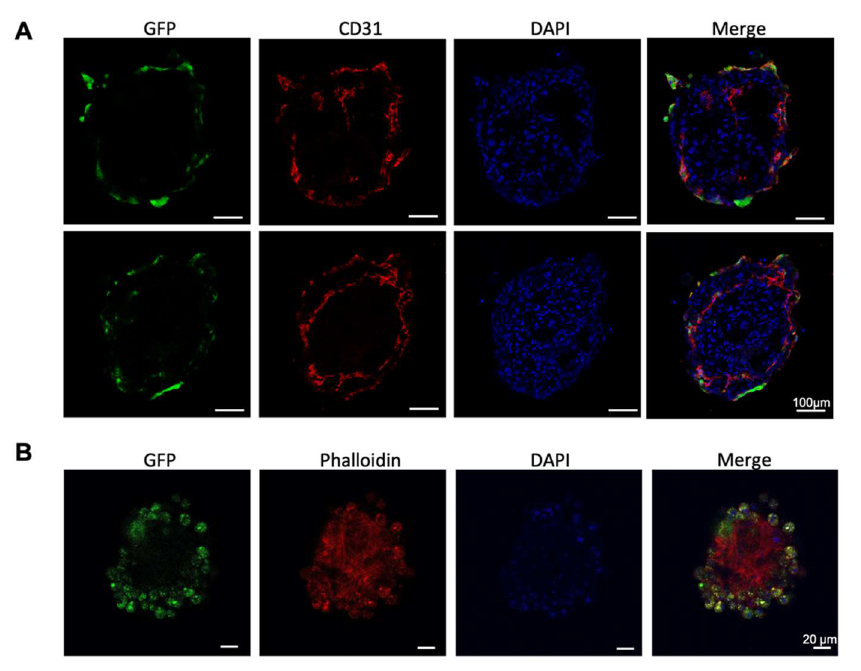
Figure 4. Endothelial cells infiltrate the normal surrounding microenvironment from vascularized PDT. Immunofluorescence analyses for vascularized PDTs. ( A ) cryosection staining; ( B ) whole mount staining. ( C ) Experimental scheme for the combination of vascularized PDT and fibrin gel. ( D ) infiltration of endothelial cells from PDO to fibrin gel. 3.4. Vascular Network Connection between Vascularized Microenvironment and Vascularized PDT The main purpose of this study is to connect the pre-vascularized PDT with the vas- cularized microenvironment. Consequently, PDTs pre-vascularized with RFP-labeled HUVECs were laid on a fibrin matrix previously vascularized with GFP-labelled HUVECs (Figure 5A). Seven days later, confocal microscopy analyses confirmed that microvessels developed by both GFP- and RFP-labeled HUVECs connected together and formed a sin- gle vascular network (Figure 5B–E), and that the red vascular network originating from PDTs extended and joined the green vascular network developed by the GFP-labeled HU- VEC cells in the fibrin matrix (Figure 5B–D). Importantly, GFP-labeled HUVECs from the